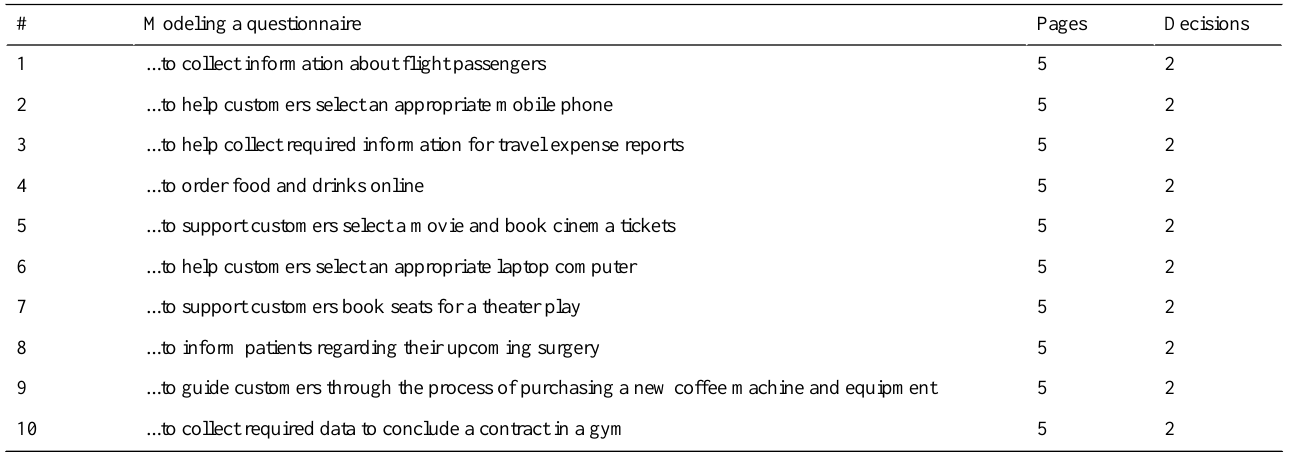
Table 2. Short description of the tasks to be modeled by